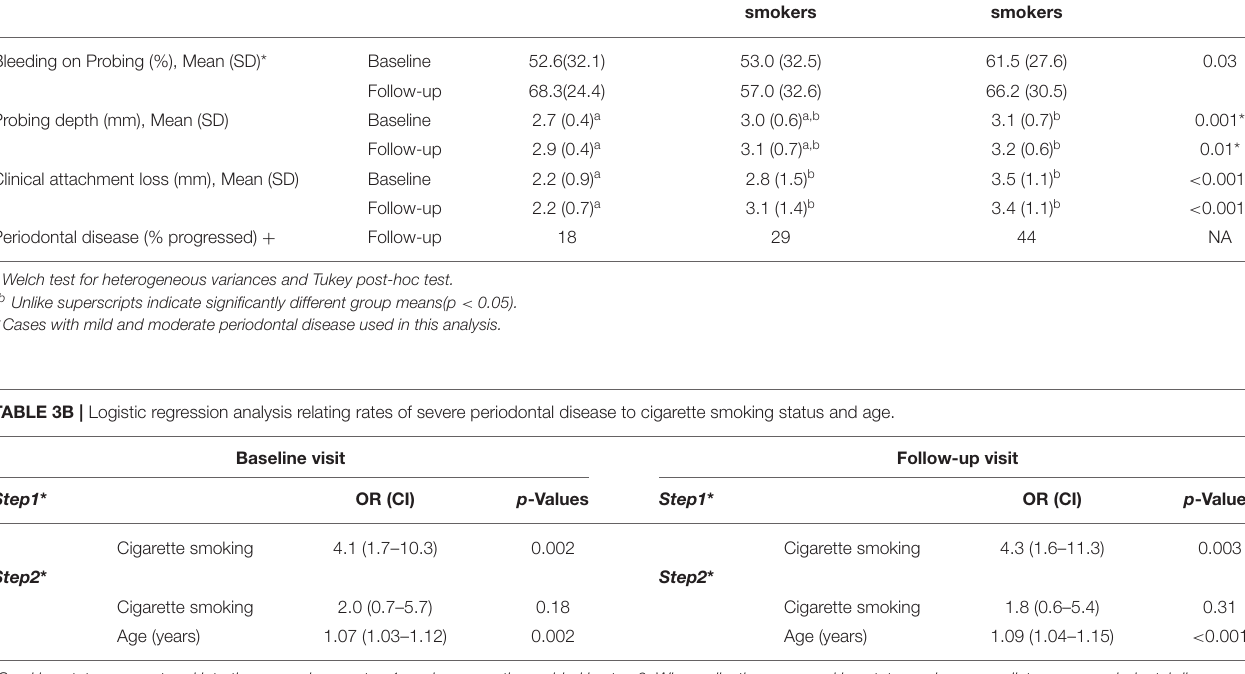
Bleeding on Probing (%), Mean (SD)*